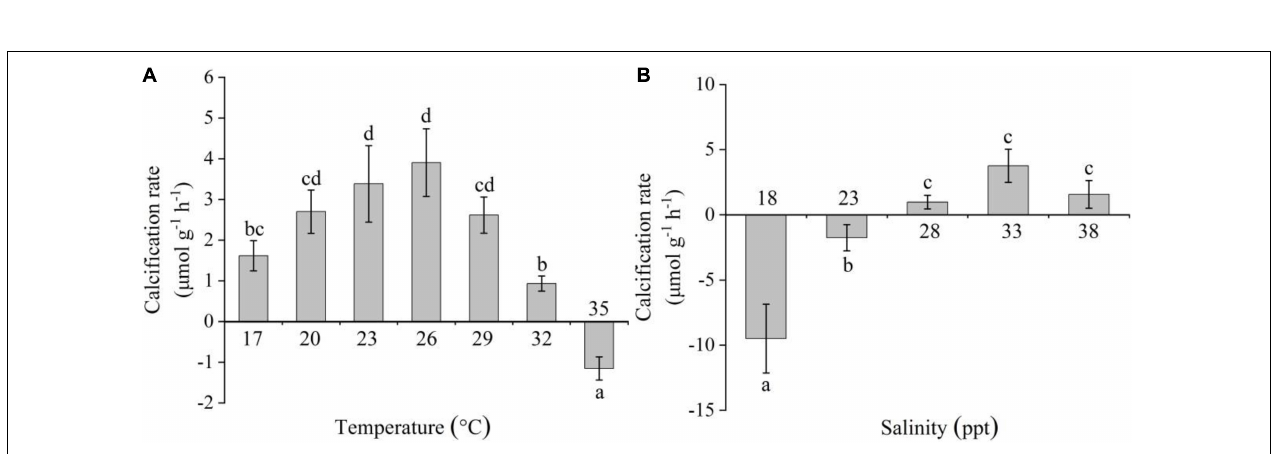
Frontiers in Marine Science |